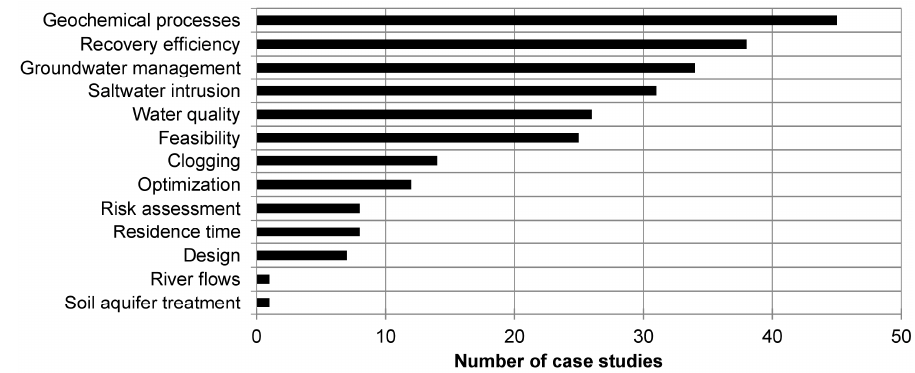
Figure 3. Distribution of well, shaft and borehole recharge modeling studies by objective (literature studies may involve multiple modeling objectives).